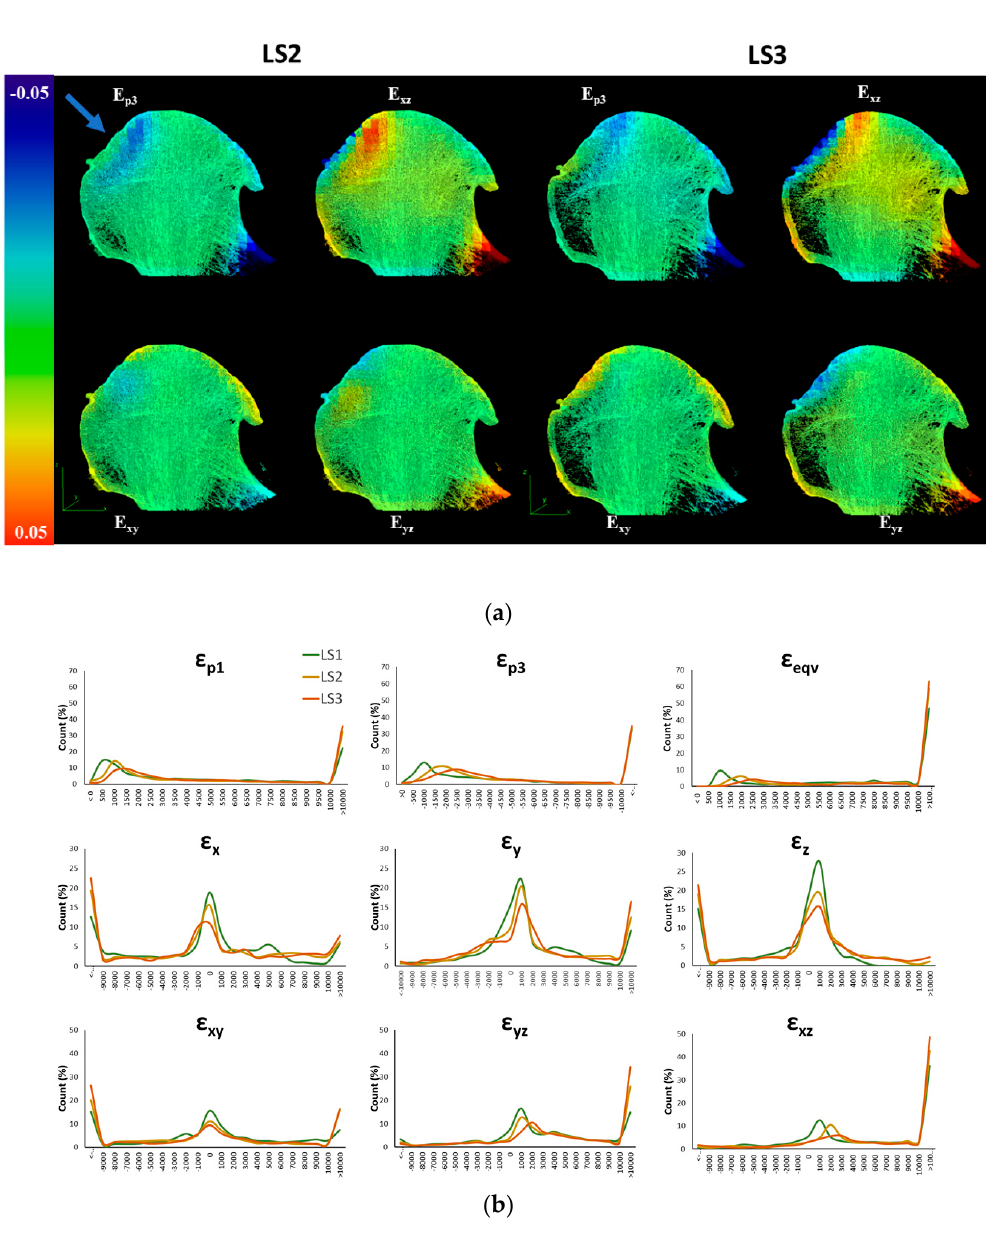
Figure A1. ( a ) 3D renderings showing 5 mm thick slices through the central region of bone with DVC output overlaid at LS2 (LEFT) and LS3 (RIGHT). The direction of applied load is indicated by the blue arrow. Strain components are noted at the top of each pictograph (TOP). ( b ) Histograms of strain distributions for each strain component ( ε p1, ε p3 ε eqv ε x ε y ε z ε xy ε yz ε xz) at the three load steps (LS1 (green), LS2 (yellow) and LS3 (orange))